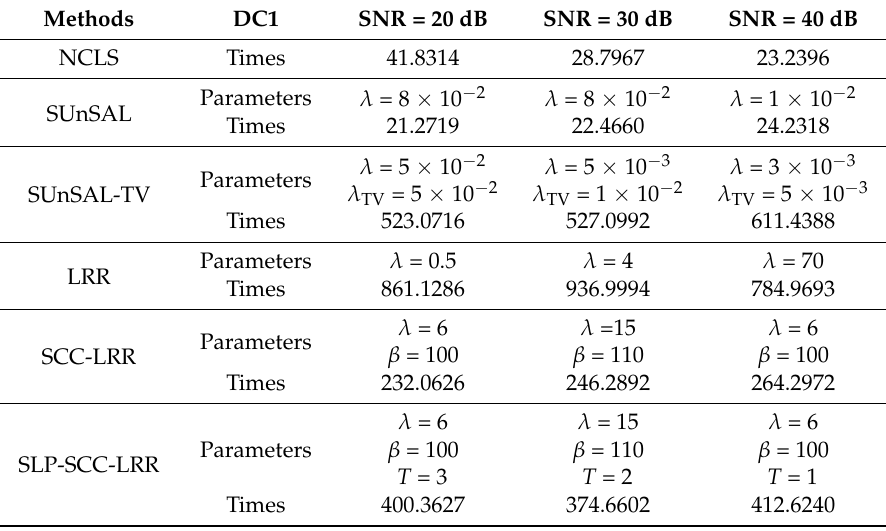
Table 2. The optimal parameters settings and running times(s) with the Simulated DATA